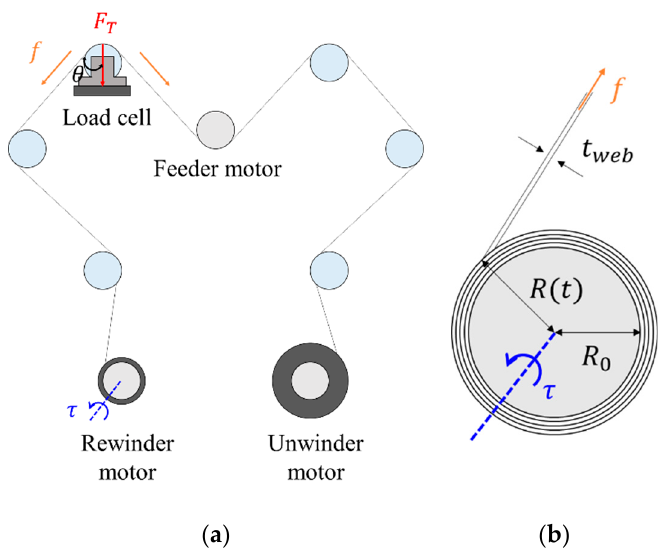
Figure 1. ( a ) Schematic of a proposed roll-to-roll (R2R system); ( b ) Schematic of a rewinder system.